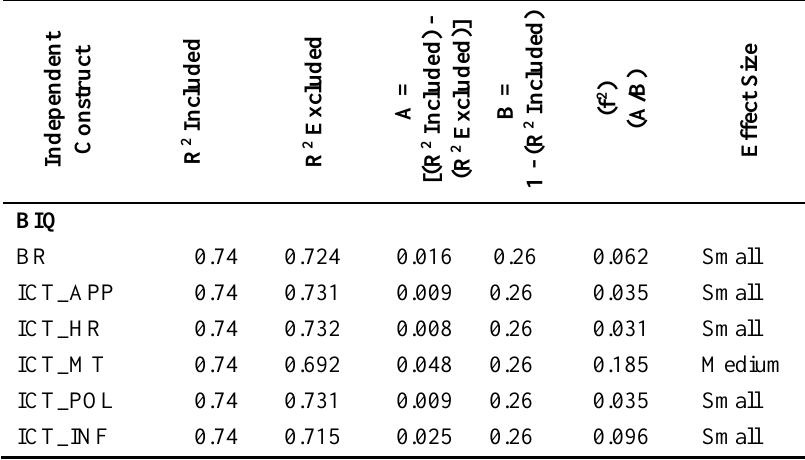
Table 7: Assessment of Effect Sizes – f 2